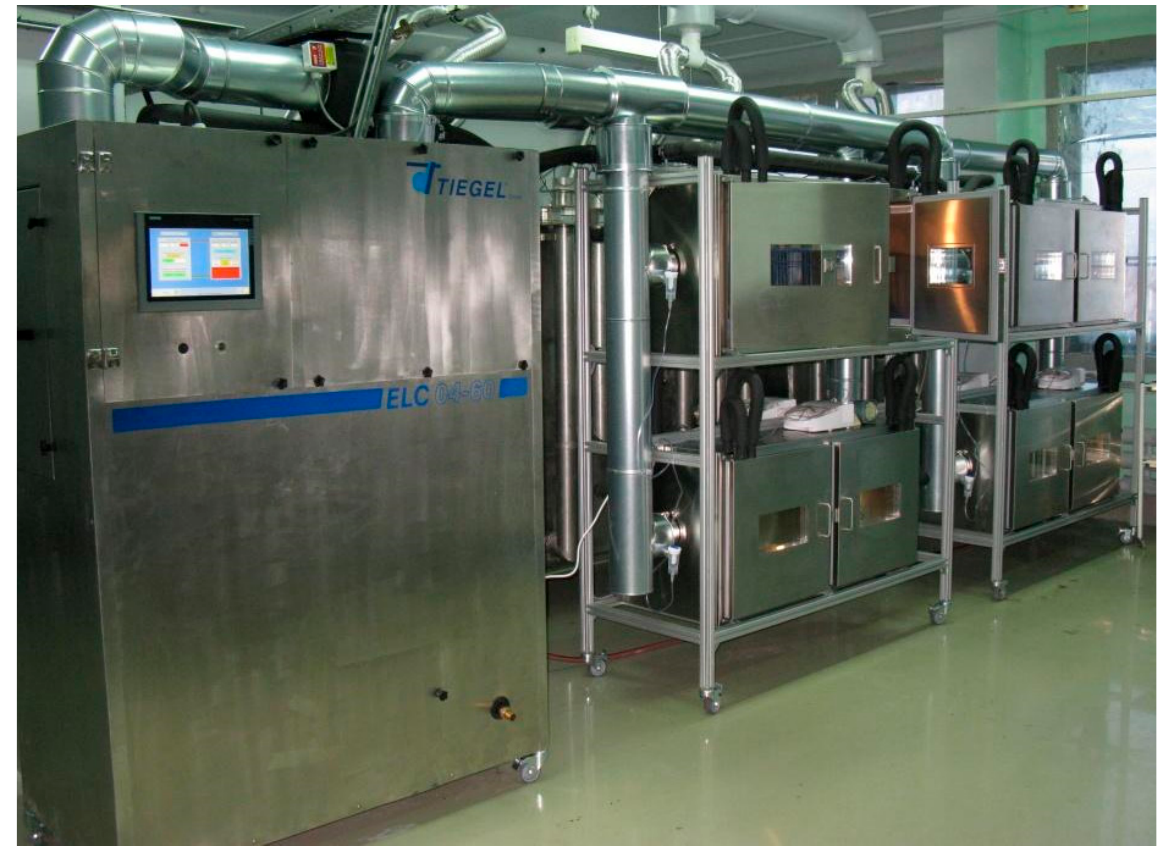
Figure 1. TIEGEL ELC 04-60 dynamic aerobiology chamber.